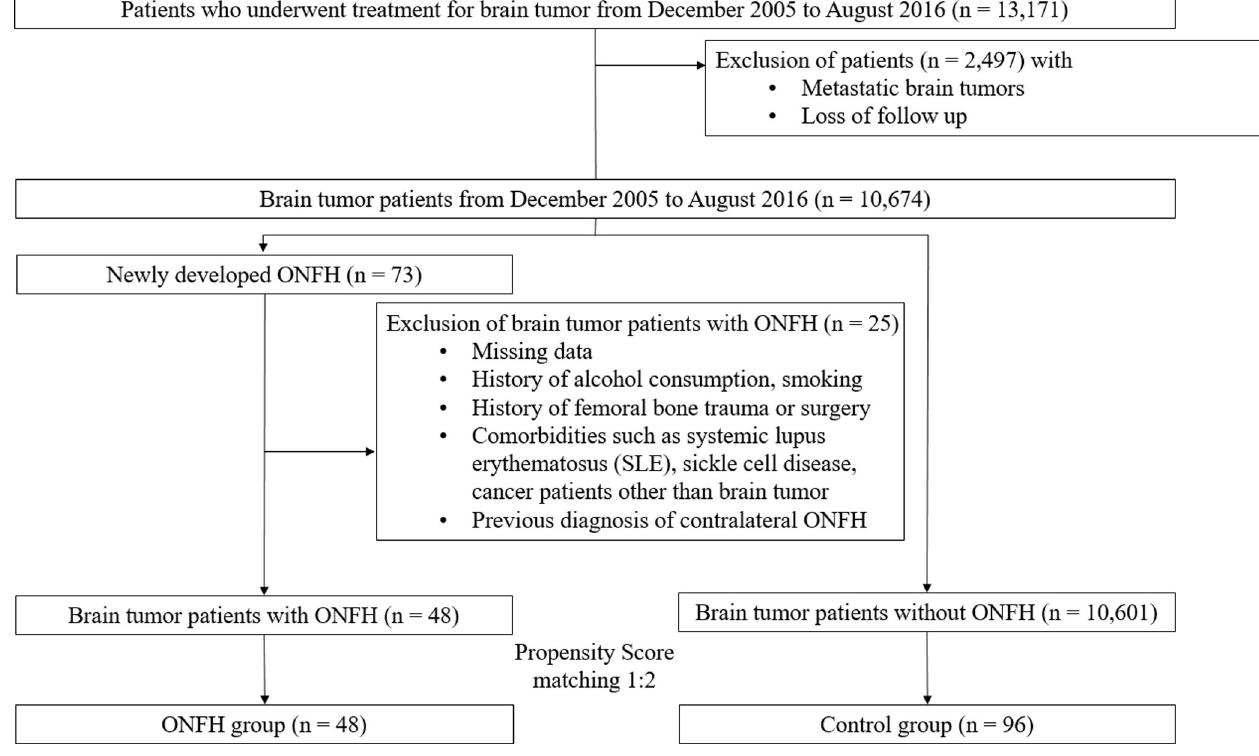
Fig 1. Flow chart of the study population. ONFH, osteonecrosis of the femoral head.